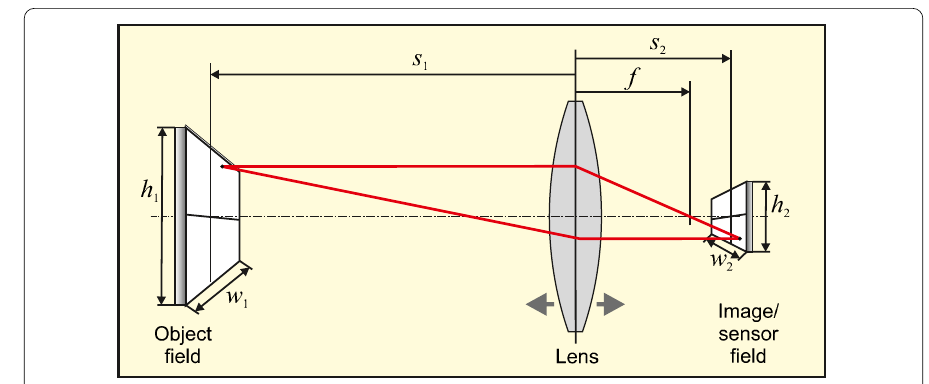
Figure 5 Schematic drawing of the imaging with a lens